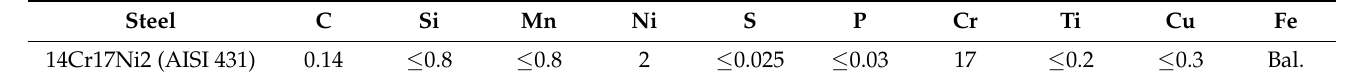
Table 1. Chemical composition of experimental steel 14Cr17Ni2,